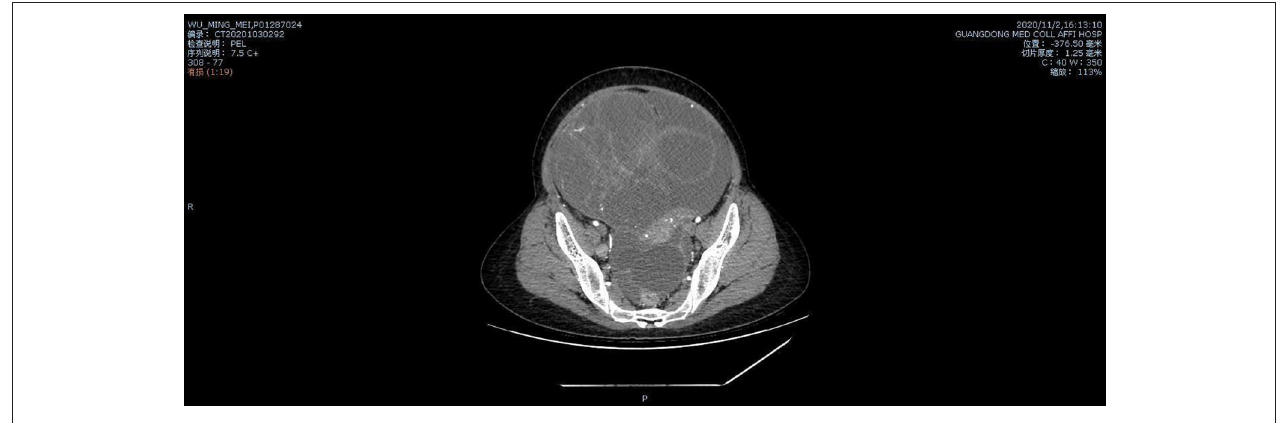
FIGURE 1 | Pelvic CT